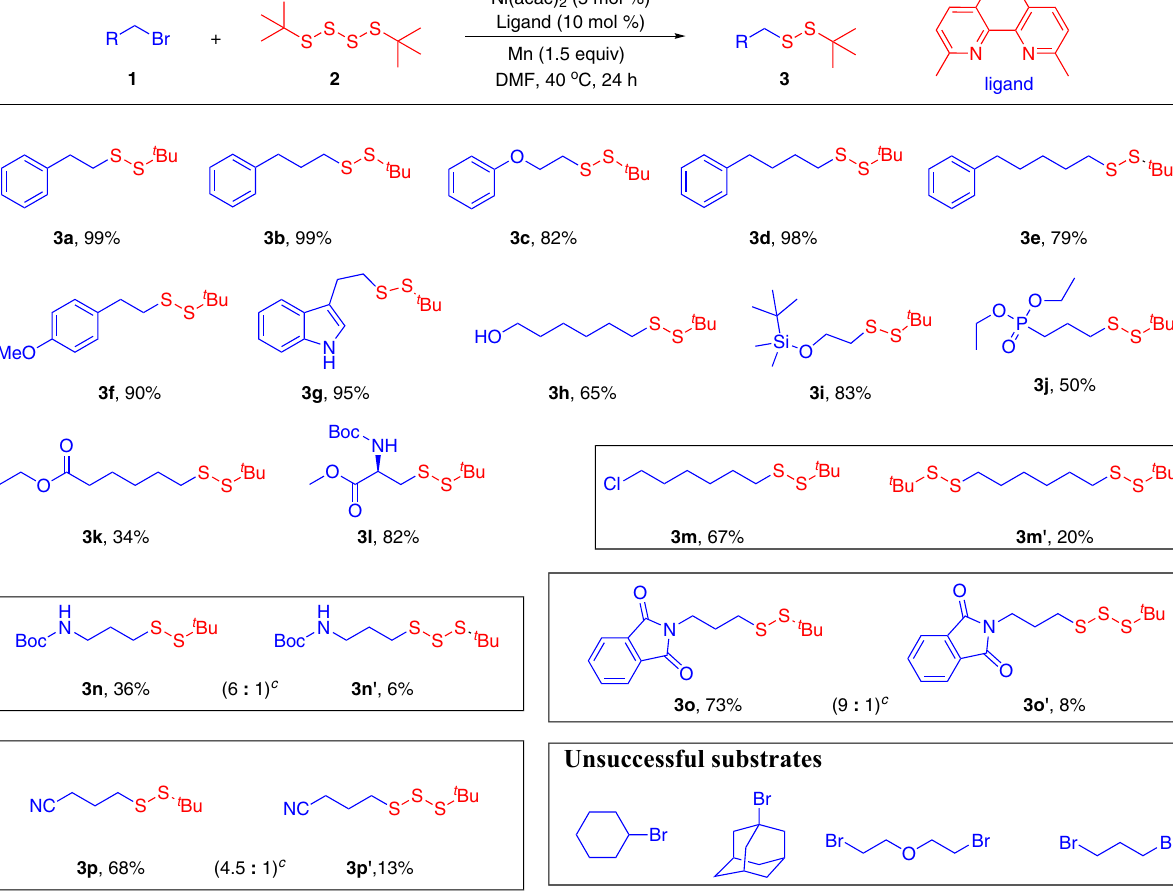
Fig. 3 Scope of primary alkyl bromides. a Reaction conditions: primary alkyl bromides 1 (0.20 mmol, 1.0 equiv.), 2a (0.24 mmol, 1.2 equiv.), Ni(acac) 2 (5.0 mol%); L1 (10 mol%), Mn (0.30 mmol, 1.5 equiv.), DMF (1 mL), N 2 atmosphere, 40 °C, 24 h. b Isolated yield. c 80